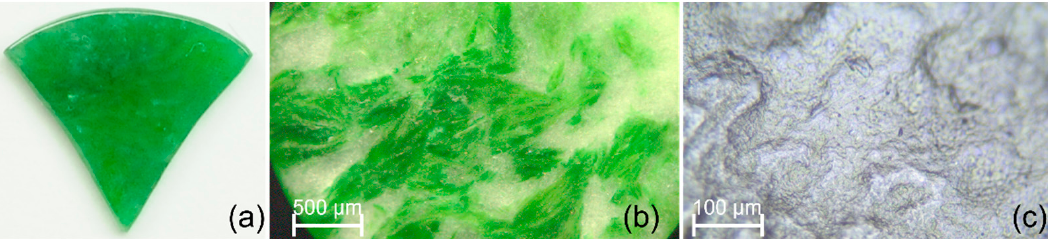
Figure 3. Mineralogical samples of ( a ) grossular/hydrogrossular and ( b ) grossular/hydrogrossular in rhodingite rock association; ( c ) rhodingite-polished tablet. Photos: M. Musa—GIG.